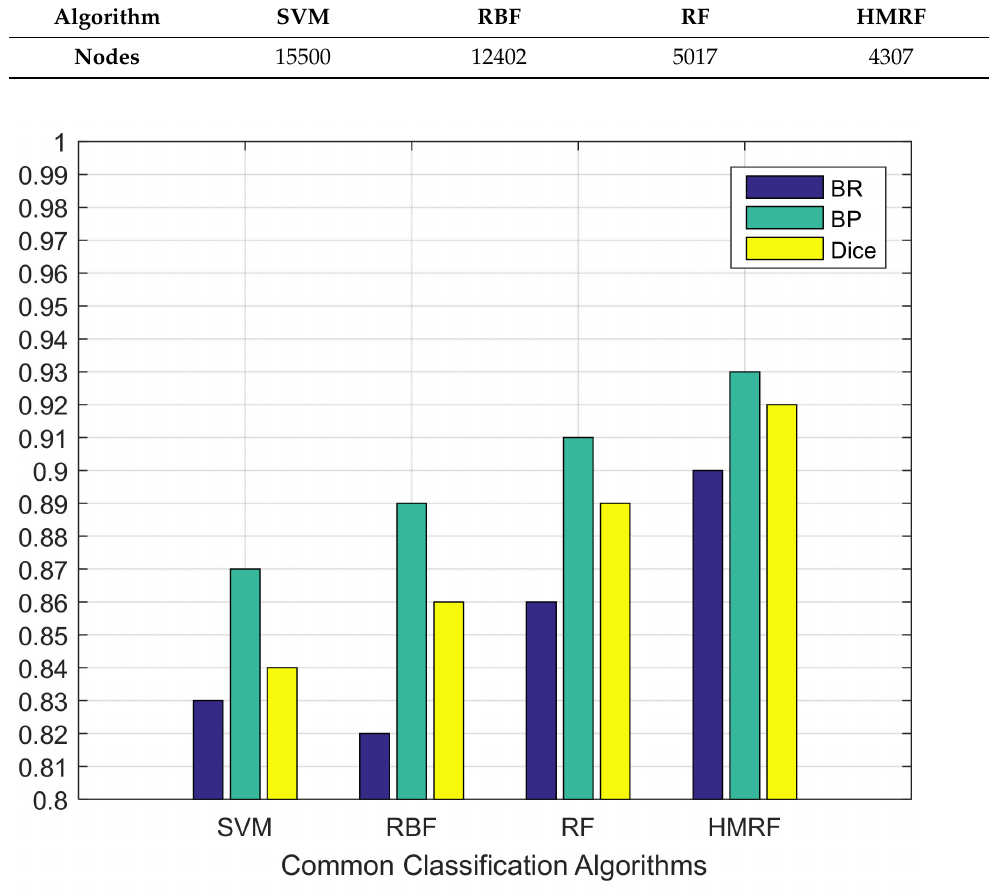
Table 4. The nodes information of common classification algorithms.